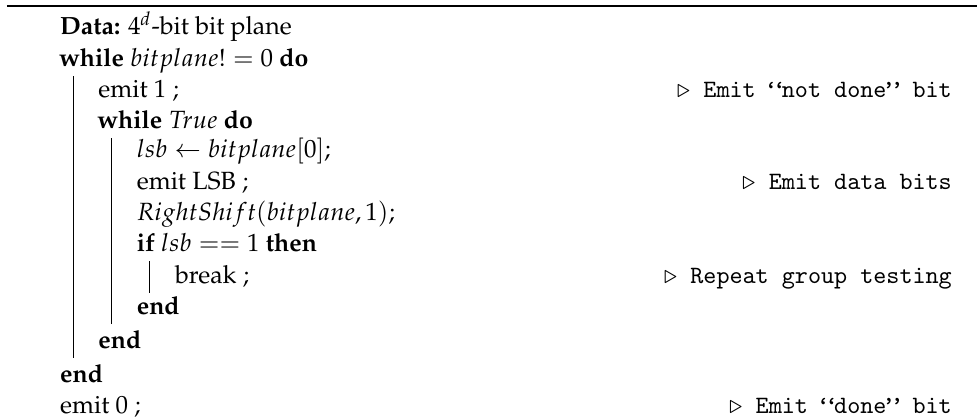
Algorithm 1: ZFP’s embedded coding stage emits bits one by one from each bit